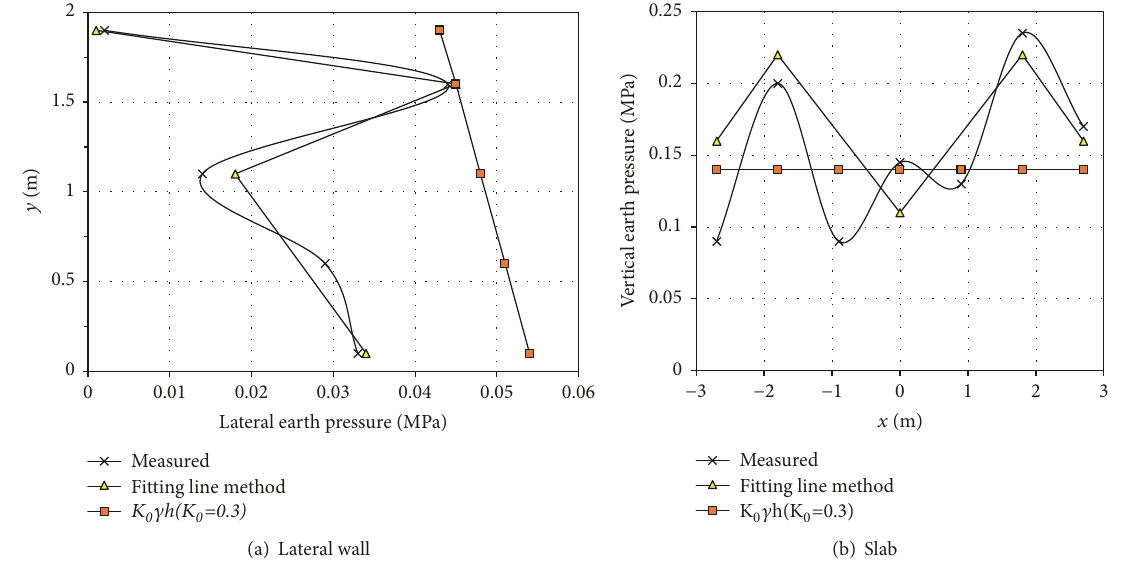
Figure 18: Earth pressure under filling height 8